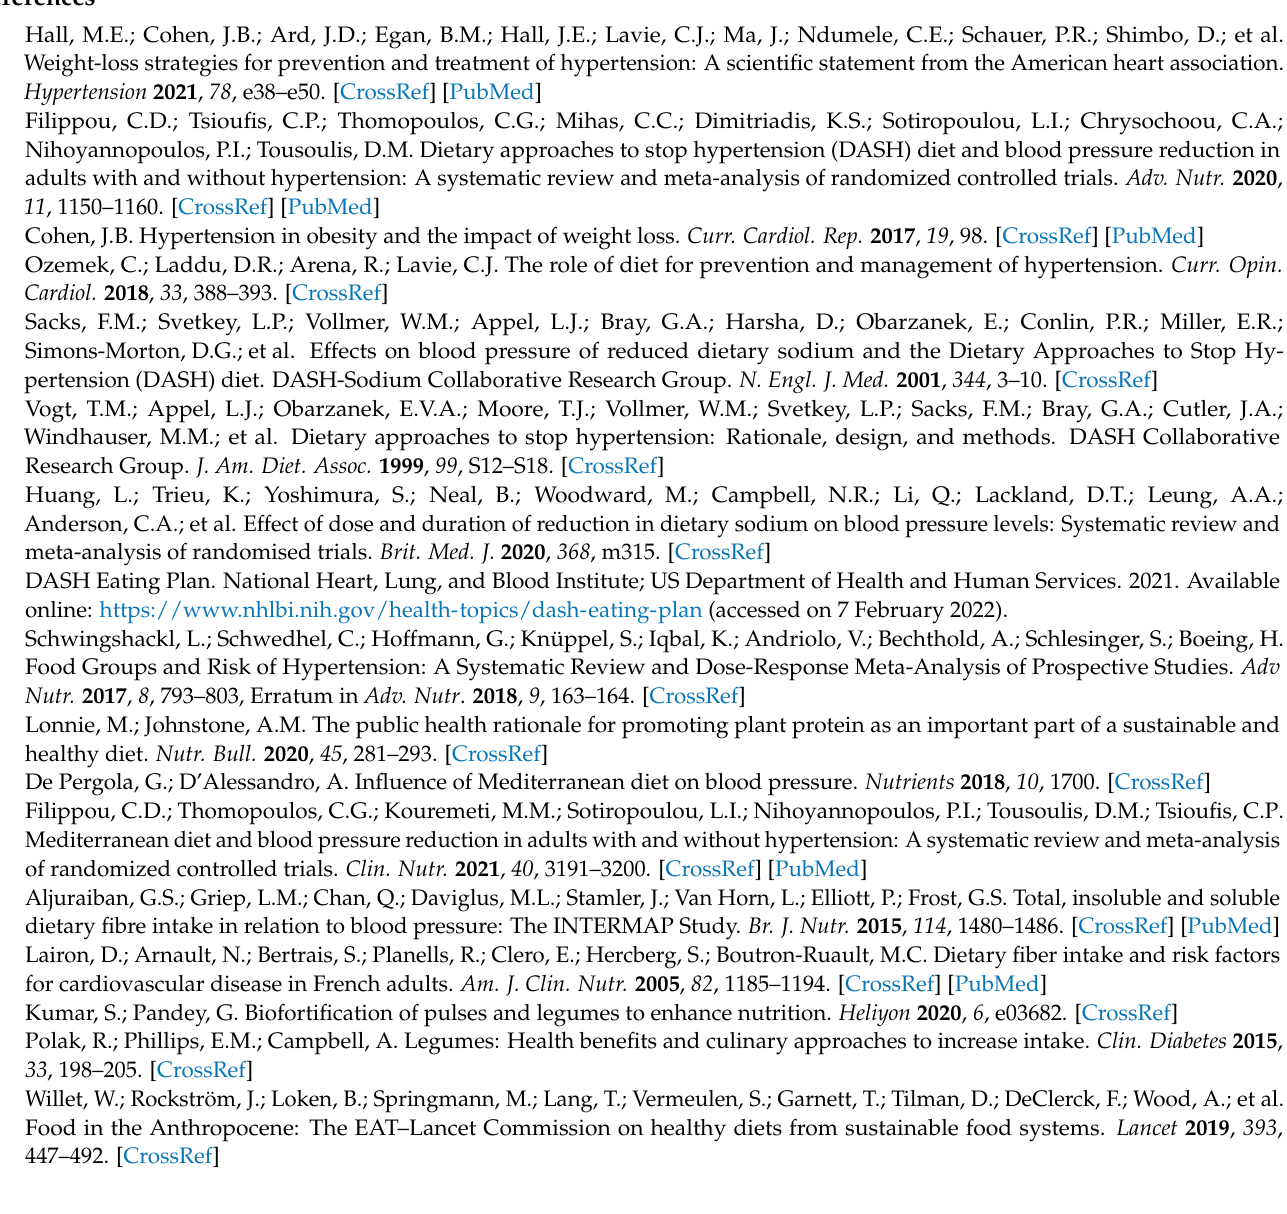
These categories are derived from the two questions in Appendix